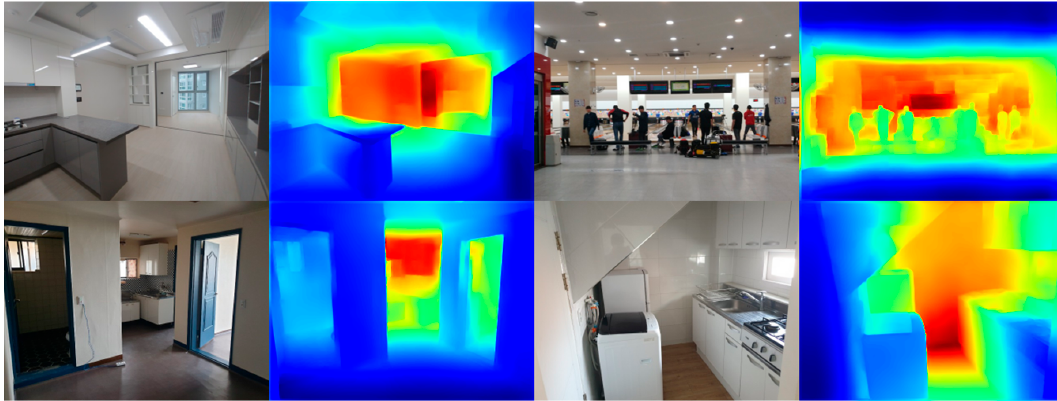
Figure 16. Result of proposed method for custom photos.